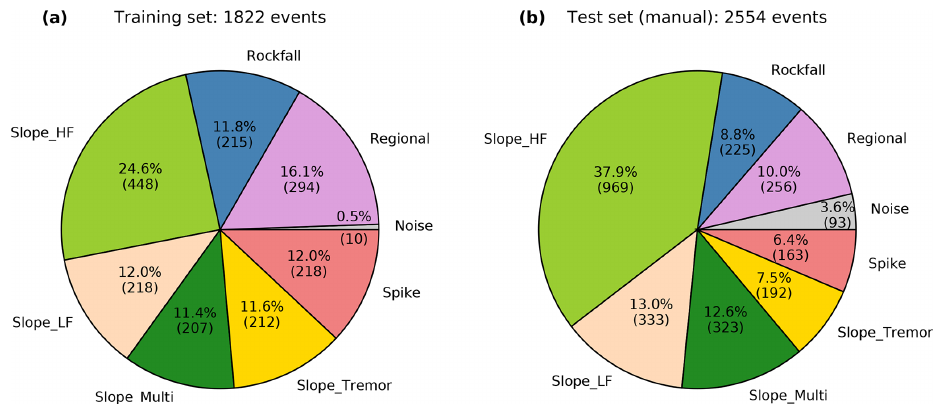
Figure B11. Pie diagrams showing the distribution of events within the different classes (a) in the training set and (b) in the test set, both expressed in terms of number of events and percentages.